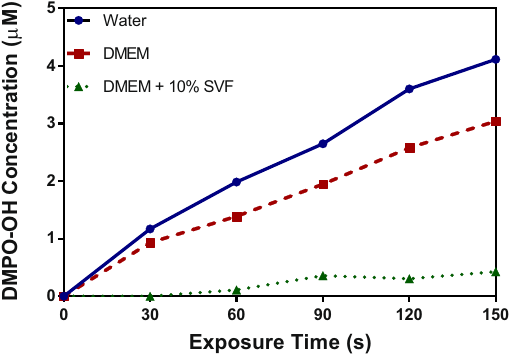
Figure 2. Variation of the concentration of DMPO-OH in water, DMEM + / − 10% FCS as a function of helium plasma jet exposure time. Half height of the second peak of the quartet EPR spectrum was chosen to represent DMPO-OH intensity.